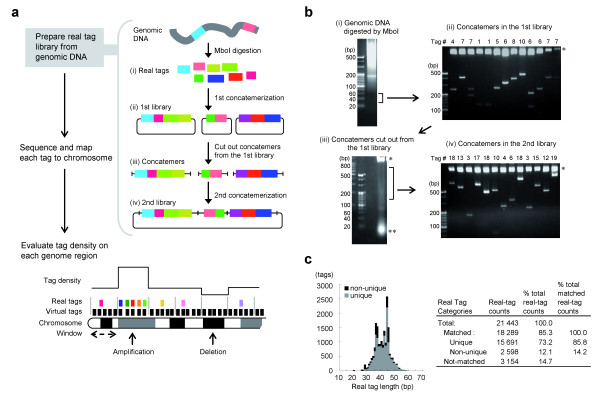
DGS and preparation of real tags. (a) Schematic outline of DGS. Colored boxes represent genomic MboI real tags. See text for details. (b and c) Preparation (b) and characterization (c) of real tags. Representative results using genomic DNA from MKN1 gastric cancer cells are shown. (b) Short fragments of MboI-digested genomic DNA (30 to 60 bp) were electroeluted from an agarose gel (i), concatenated and subcloned. Resultant recombinant plasmids were pooled to generate the 1st library (ii). Long concatemers (140 to 800 bp) were excised from 1st library vectors, electroeluted (iii), concatenated and subcloned. The resultant recombinant plasmids represent 2nd library clones (iv). The number of tags contained in each clone is shown at the top of each lane. Inserts were examined by XhoI/SacI digestion in panels (ii) and (iv). *, vector fragments; **, SpeI/PstI digestion of the multiple-cloning site without insert. (c) Actual number of real tags from the 2nd library is shown in the histogram (left), and their characteristics are summarized (right).